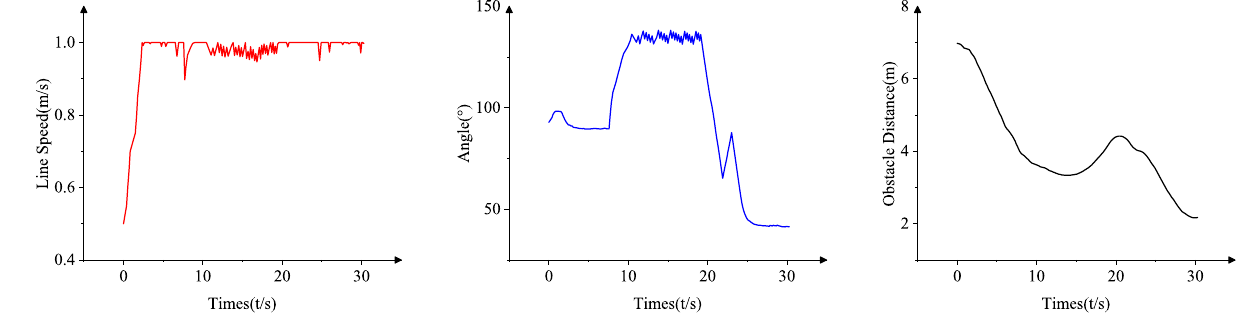
Figure 24. Overtaking situation for the improvement of weighting coefficients based on fuzzy control.